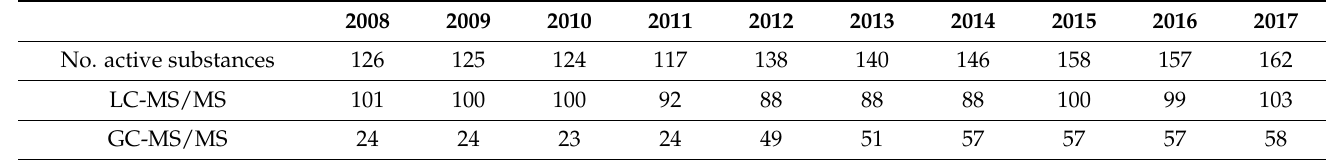
Table 4. Number of active substances analysed by year (2008–2017) considering the detection